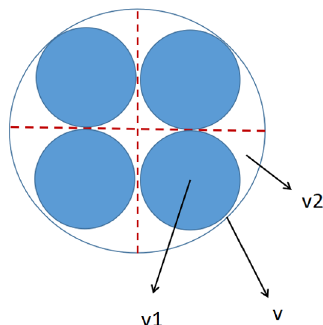
Figure 7 . The specific volume is composed of the maximum volume sphere and the interval.